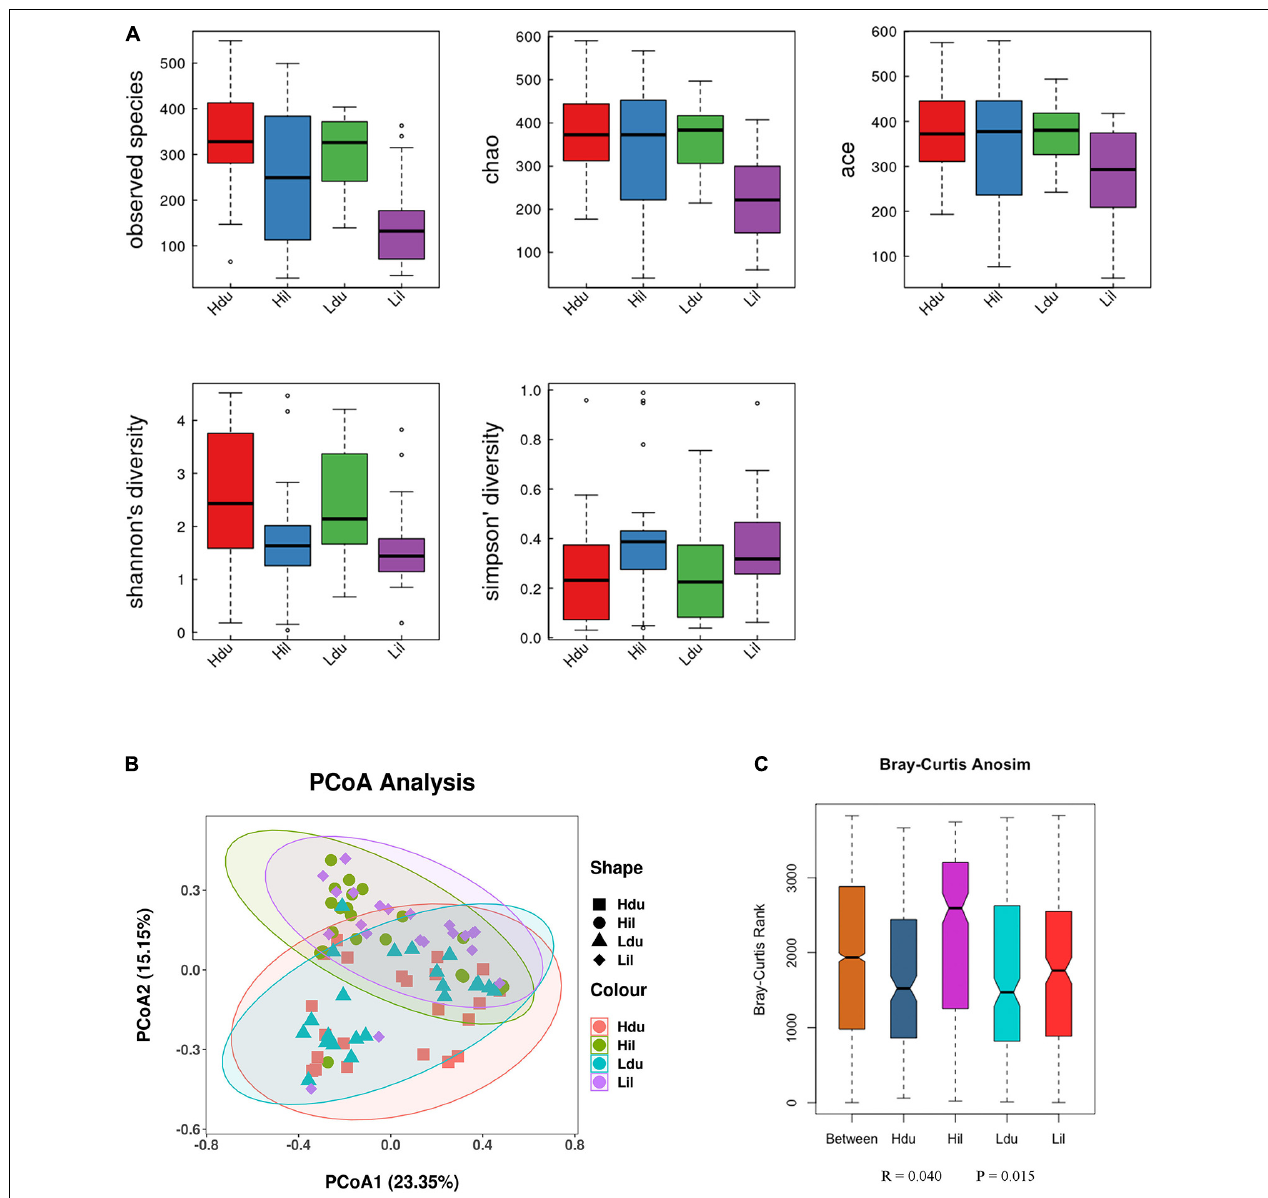
FIGURE 2 | Differences in bacterial diversity, richness, and structures in the duodenum and ileum of HFE and LFE groups. (A) Differences in community diversity and richness between the duodenum and ileum. (B) Principal co-ordinates analysis (PCoA) plot of bacterial community structure between the duodenum and ileum. Hdu and Ldu, HFE group and LFE group of the duodenum. Hil and Lil, HFE group and LFE group of the ileum. (C) Plot of analysis of similarities